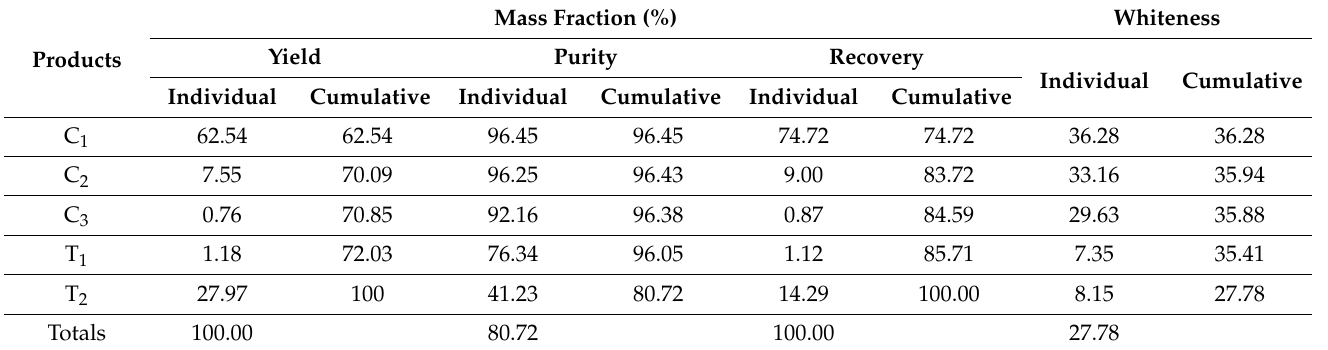
Figure 6. Scavenging test flowsheet of the recovery of gypsum from phosphogypsum. Table 3. Scavenging test results of the recovery of gypsum from